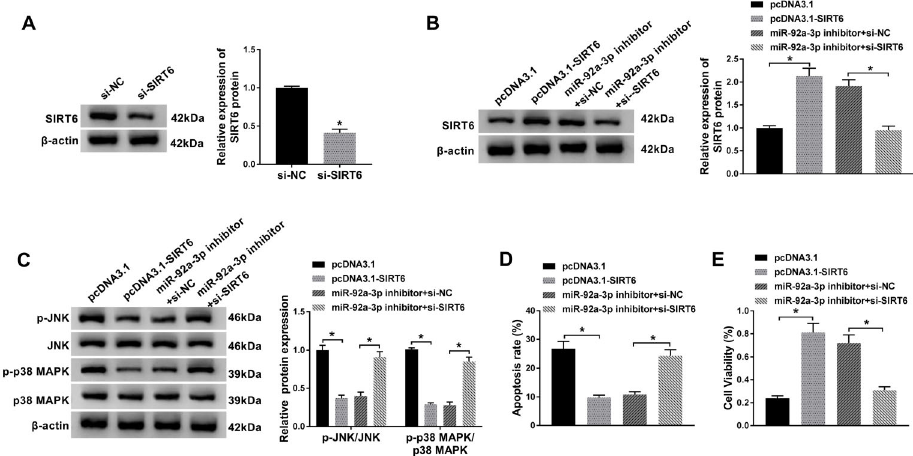
Figure 5. iR-92a-3p was involved in oxidized low-density lipoprotein (ox-LDL)-induced cell apoptosis via targeting SIRT6/MAPK signaling pathway. Human umbilical vein endothelial cells (HUVECs) were treated with 50 m g/mL of ox-LDL for 48 h and transfected with pcDNA3.1, pcDNA3.1-SIRT6, miR-92a-3p inhibitor + anti-negative control (NC), or miR-92a-3p inhibitor + si-SIRT6. A – C , Western blot assays were carried out to evaluate expression levels of SIRT6, p-JNK/JNK, and p-p38 MAPK/p38 MAPK in transfected HUVECs. D , Apoptosis of transfected HUVECs was determined by fl ow cytometry assay. E , MTT analysis was used to assess cell viability of HUVECs post-transfection. Data are reported as means ± SD with three replicates. *P o 0.05 (ANOVA).